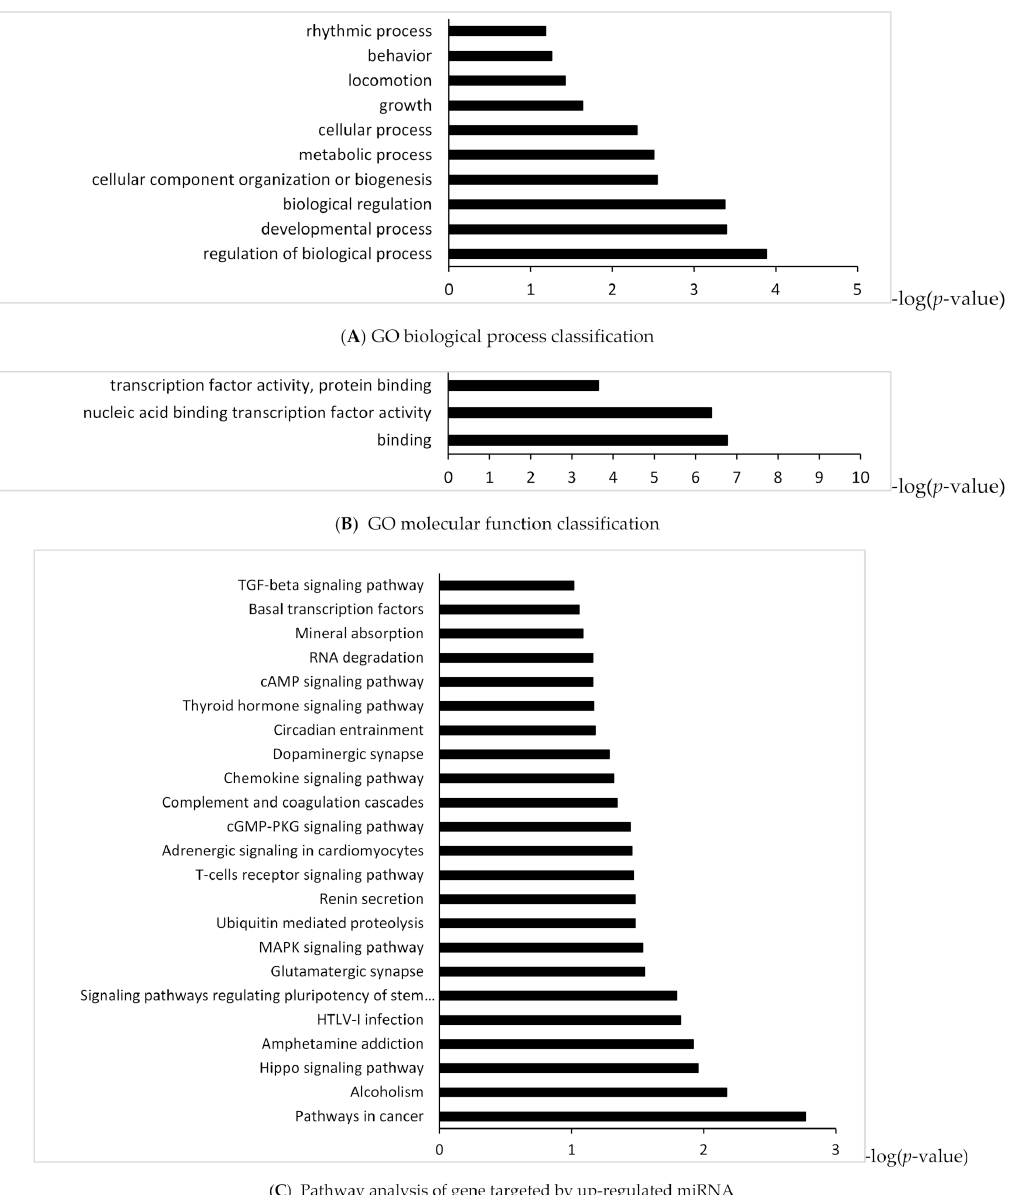
Figure 2. Gene Ontology and KEGG enrichment analysis of target genes of up-regulated miRNA in vitreous of high myopic MH